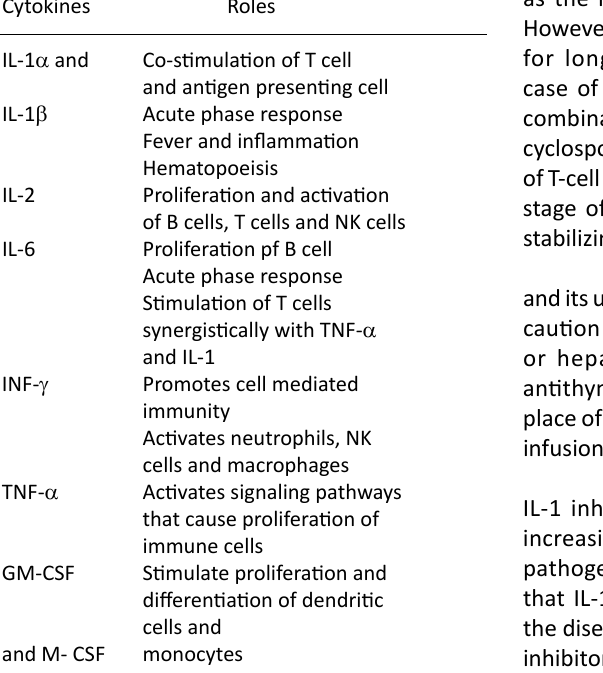
Table 6. Major cytokines inducing MAS Cytokines